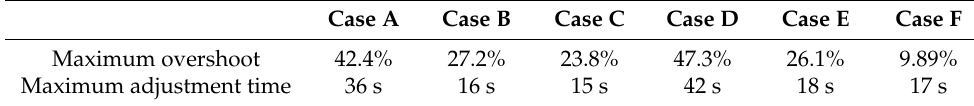
Table 5. The dynamic response index of course tracking